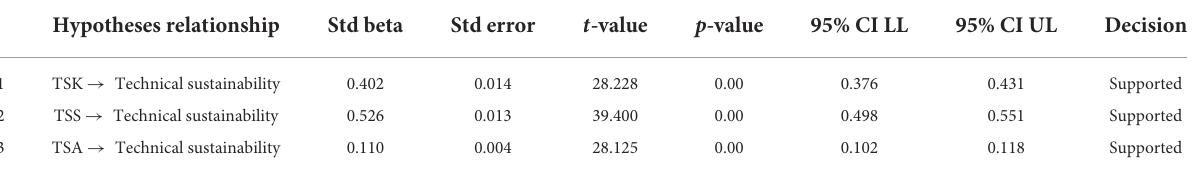
TABLE 5 Structural model hypothesis